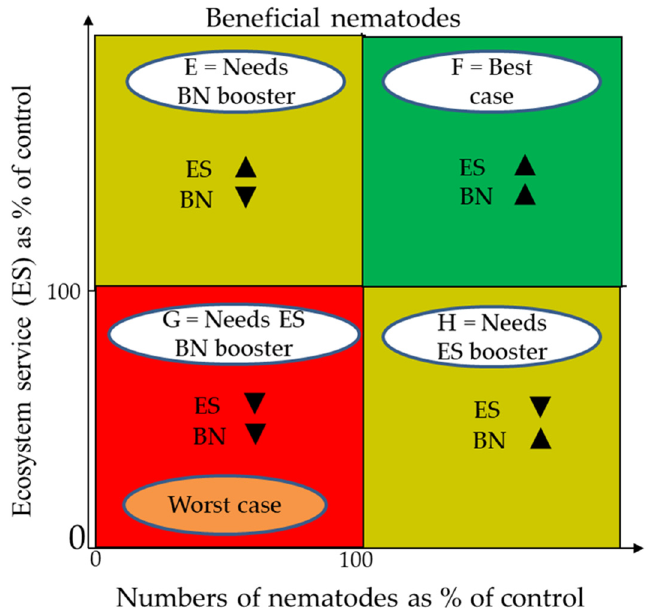
Figure 1. Modified fertilizer use efficiency (FUE) model analysis quadrants separating best (green), worst (red) and variable (olive green) outcomes of ecosystem service (ES) and beneficial nematodes (BN; [9]) as indicators of the biological component of the SFW. Increased ( ▲ ) and decreased ( ▼ ) responses and what they mean (=) are indicated. 100% on either axis is a control.